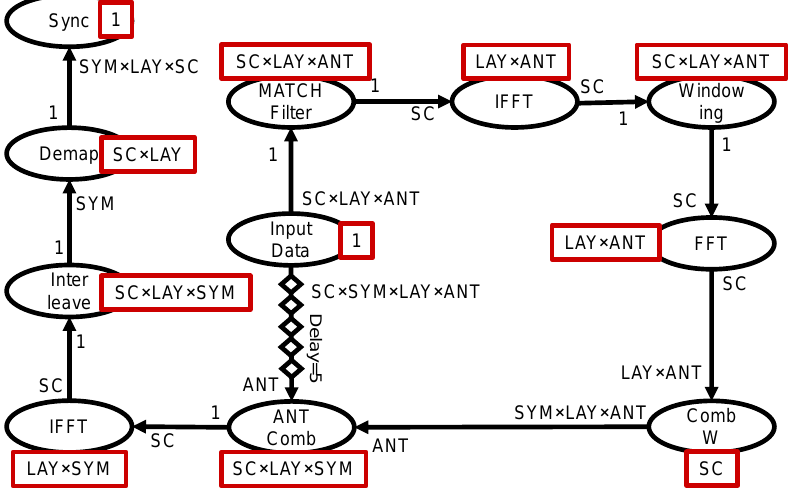
Figure 3. The SDF graph of an uplink stream application in PHY-Bench.